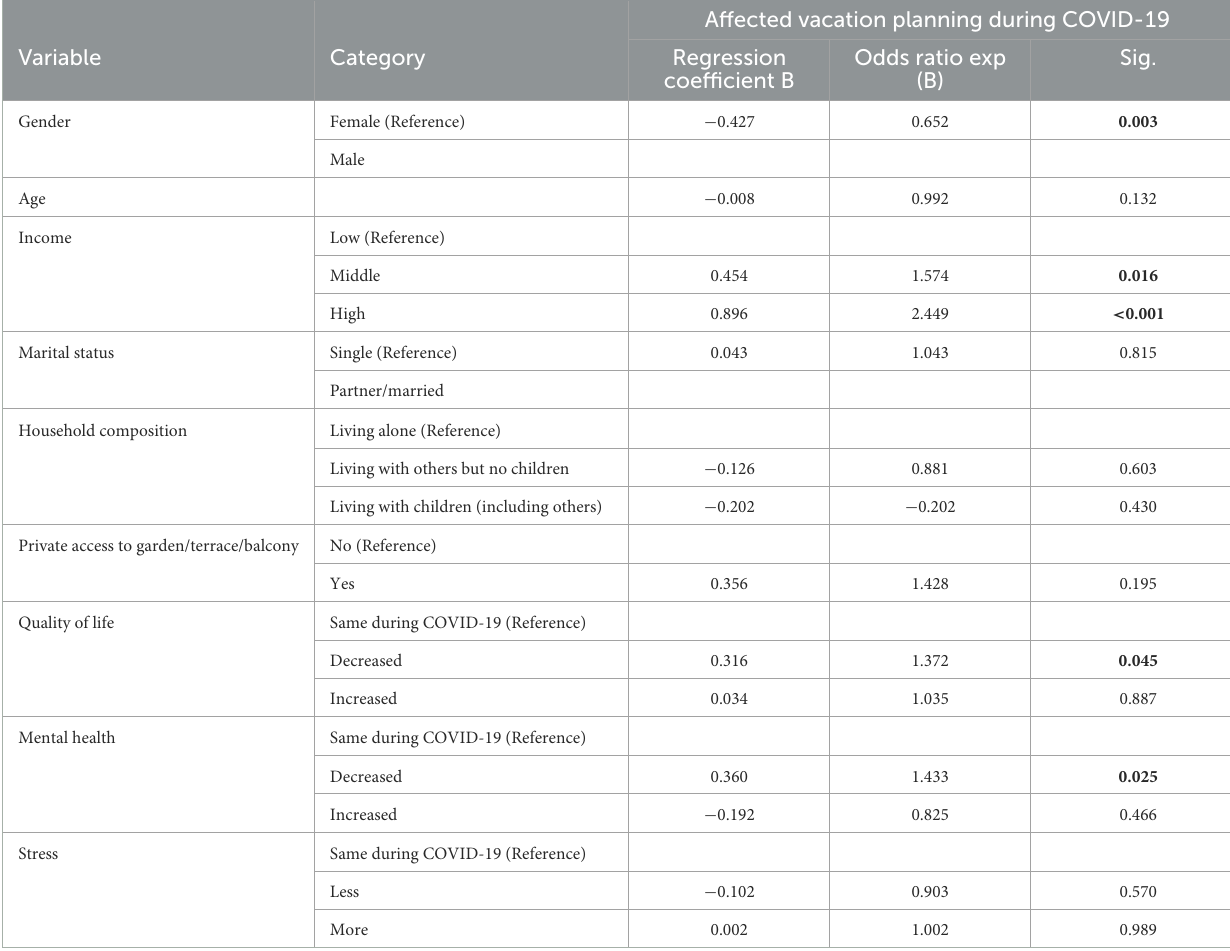
TABLE 3 Results of the binary logistic regression model examining associations between vacation planning during the COVID-19 pandemic and several variables ( n = 1,809).